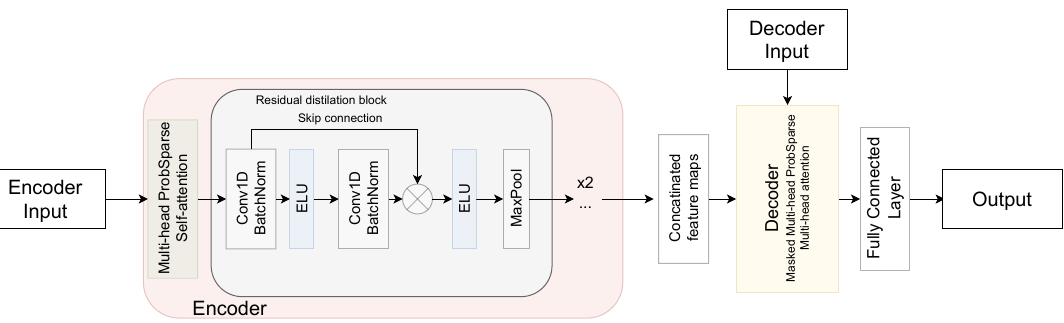
Figure 1. The proposed ResInformer